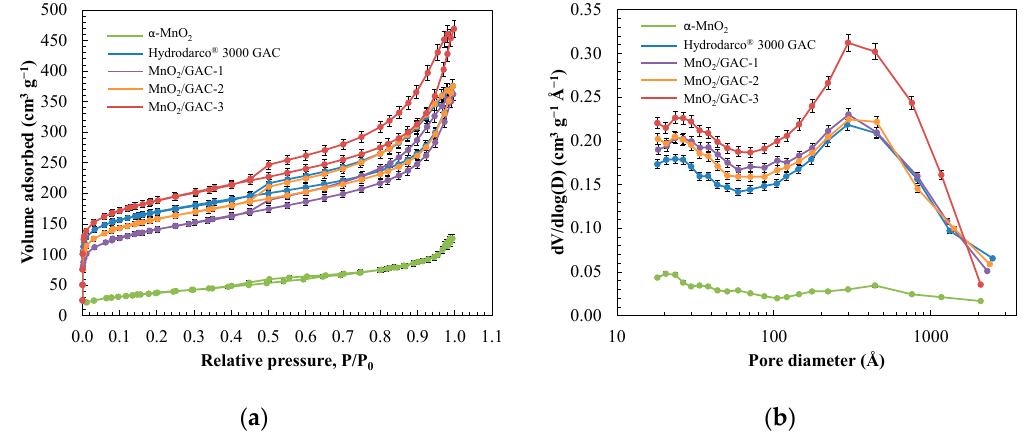
Figure 5. N 2 adsorption isotherm ( a ) and pore-size distribution ( b ) of synthesised α -MnO 2 nanoparticles, commercial activated carbon Hydrodarco ® 3000, and three MnO 2 /GAC composites synthesised in this study.